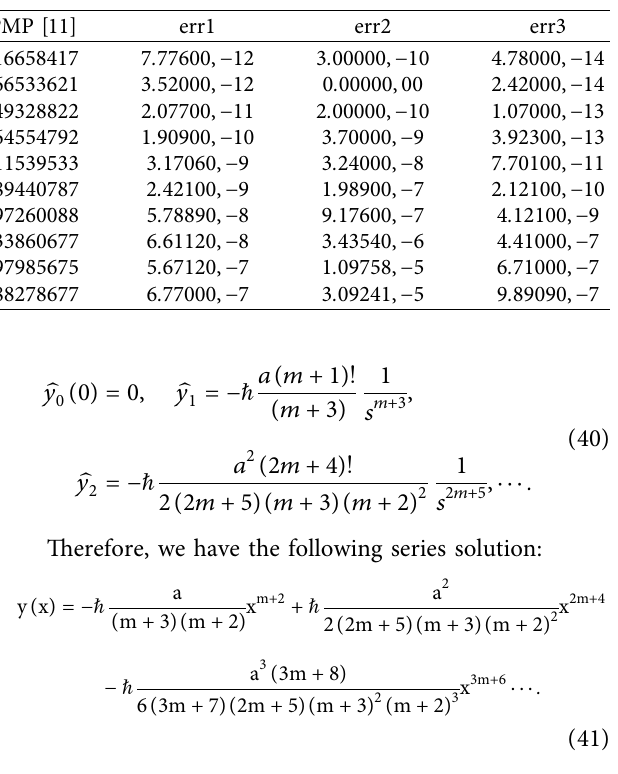
Table 1: Comparison of the numerical solutions and absolute errors obtained by our ALHPM method, ALHPMP, and collocation scheme for Example